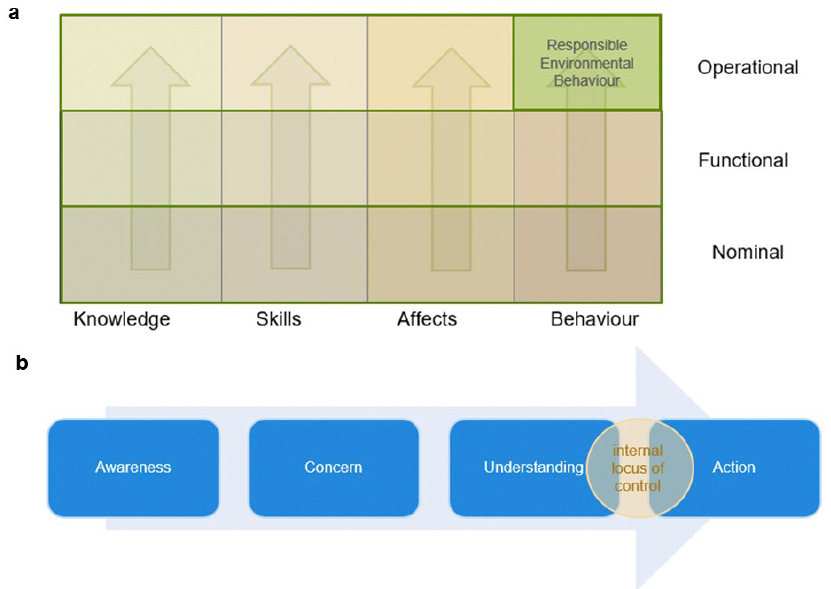
Figure 1. Developing Environmental and Energy-responsible literacy. ( a ) From rudimentary knowledge and budding awareness to responsible environmental behavior: the environmental literacy continuum. ( b ) The stages of developing environmental and energy-responsible literacy in